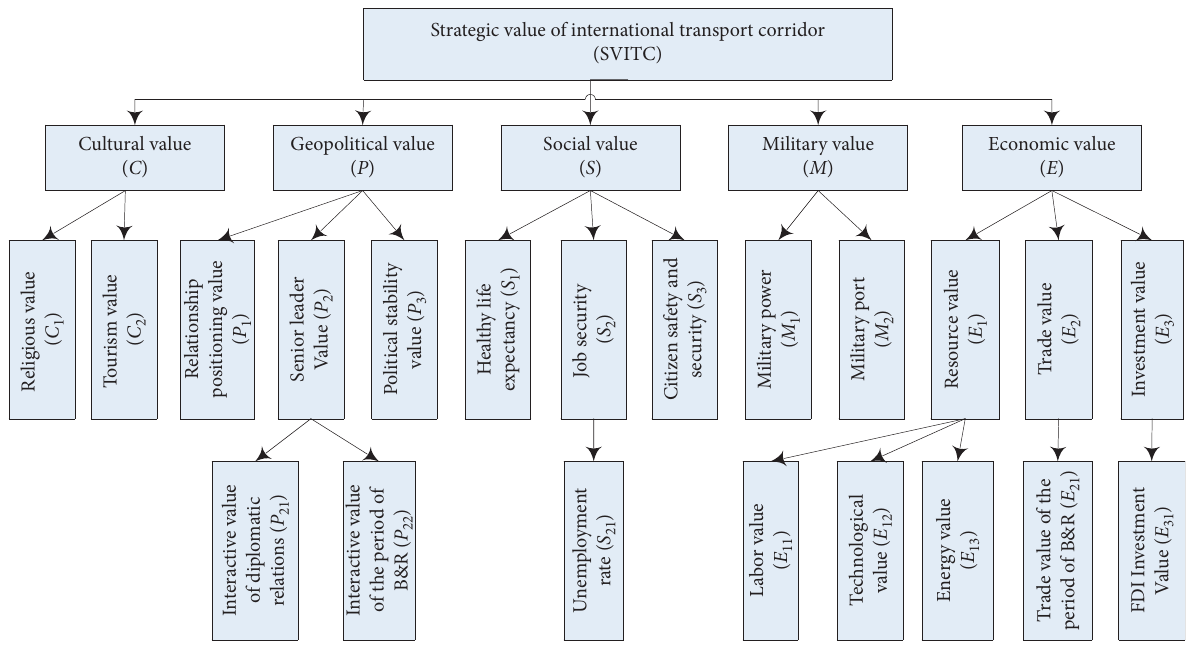
Figure 1: An evaluation index system of SVITC.